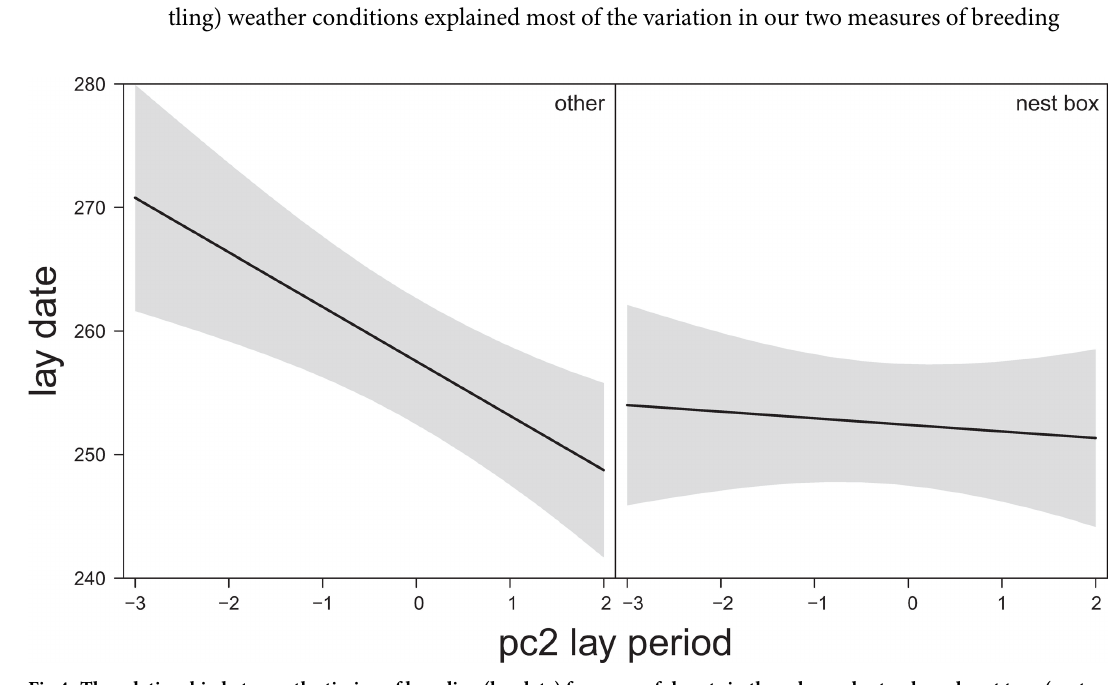
Fig 4. The relationship between the timing of breeding (lay date) for successful nests in the urban subset only and nest type (nest box versus other) in interaction with temperature and rainfall pc2 (estimate 0.28 ± 0.09 SE, χ 2(n = 159) = 9.46, P = 0.002) [negative values: High average and high min temperatures with high precipitation (total sum of rain and rain intensity); positive values: Low temperatures and low precipitation (i.e., cold and dry)] during the egg-laying period based on predicted values of LMM, 95% CIs in shaded grey. Model details in Table